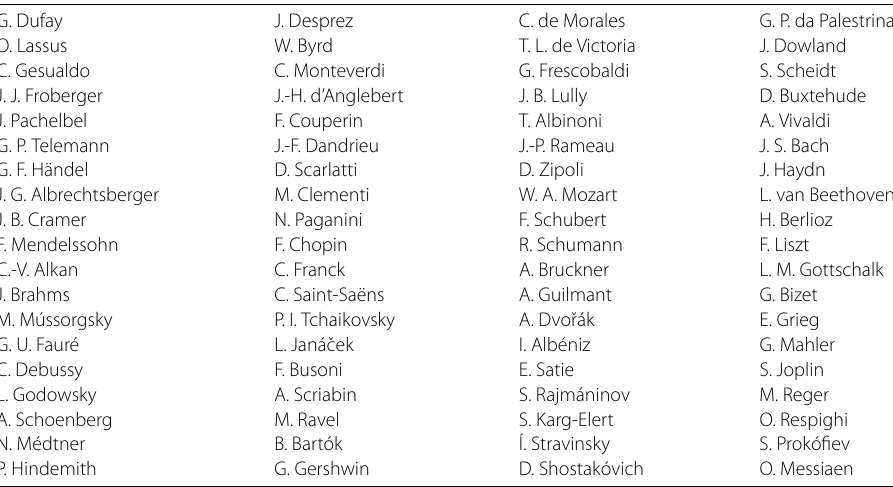
Table 1 Name of the 76 classical composers in the Kunstderfuge corpus analyzed in this paper. The order is chronological (established by the year of birth) G. Dufay